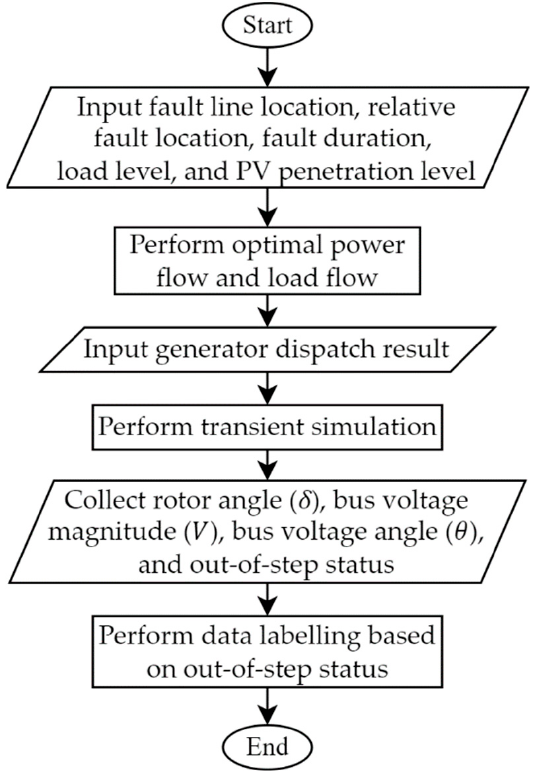
Figure 2. Data generation workflow. Table 1. Scenarios of variations in electric power system operating conditions.